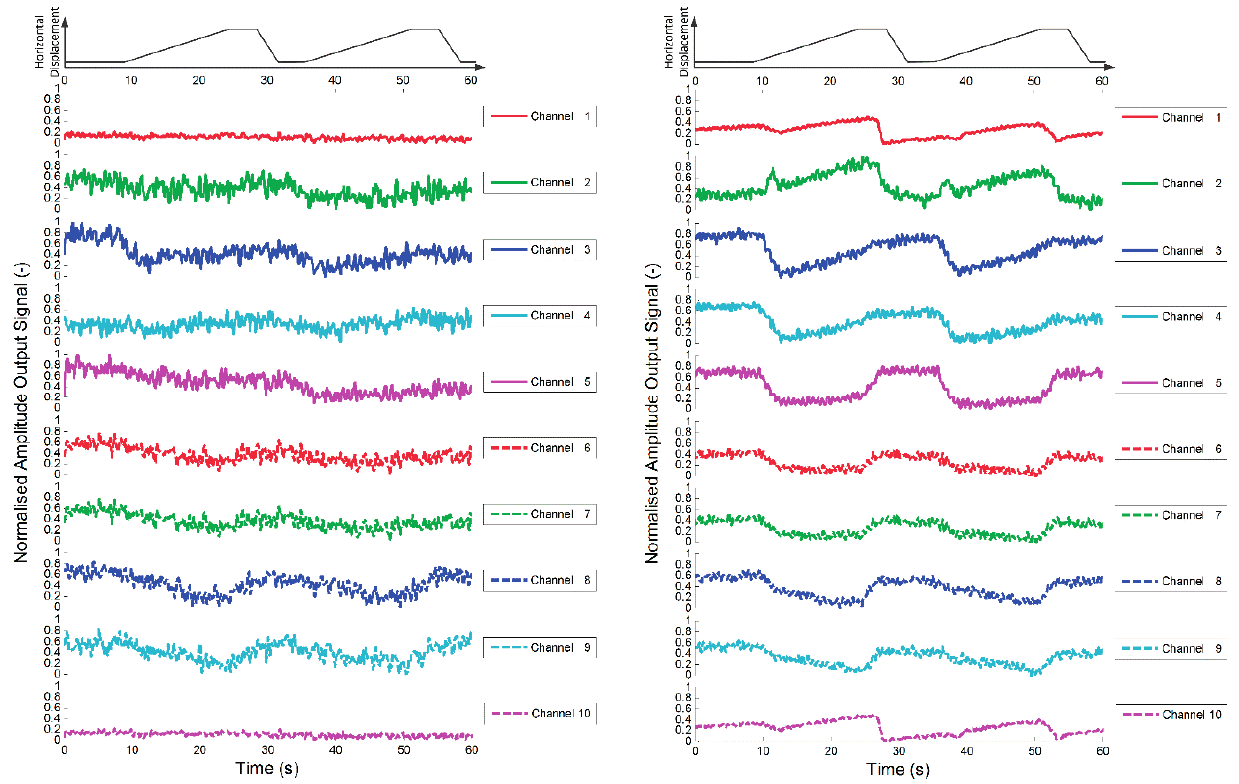
sensor ( i.e. , alginate with fibroblasts) outputs during sliding test. The first rows of each plot show the horizontal displacement of the stimuli, that were a hemisphere 2.5 mm in diameter (top left), a hemisphere 5 mm in diameter (top right and bottom left), a hemisphere 10 mm in diameter (bottom